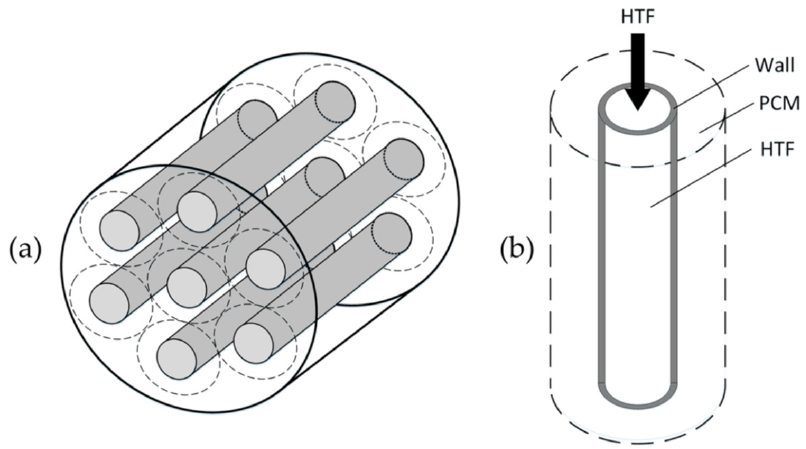
Figure 4. ( a ) Cylindrical shell-tube LHS and ( b ) single storage element (Copyright 2017 Kuboth et al. (http://creativecommons.org/licenses/by/4.0/), accessed on 26 September 2022) [28]. Table 3. Parameters of LHS (Figure 5) (adapter, copyright 2021 Pakalka et al.